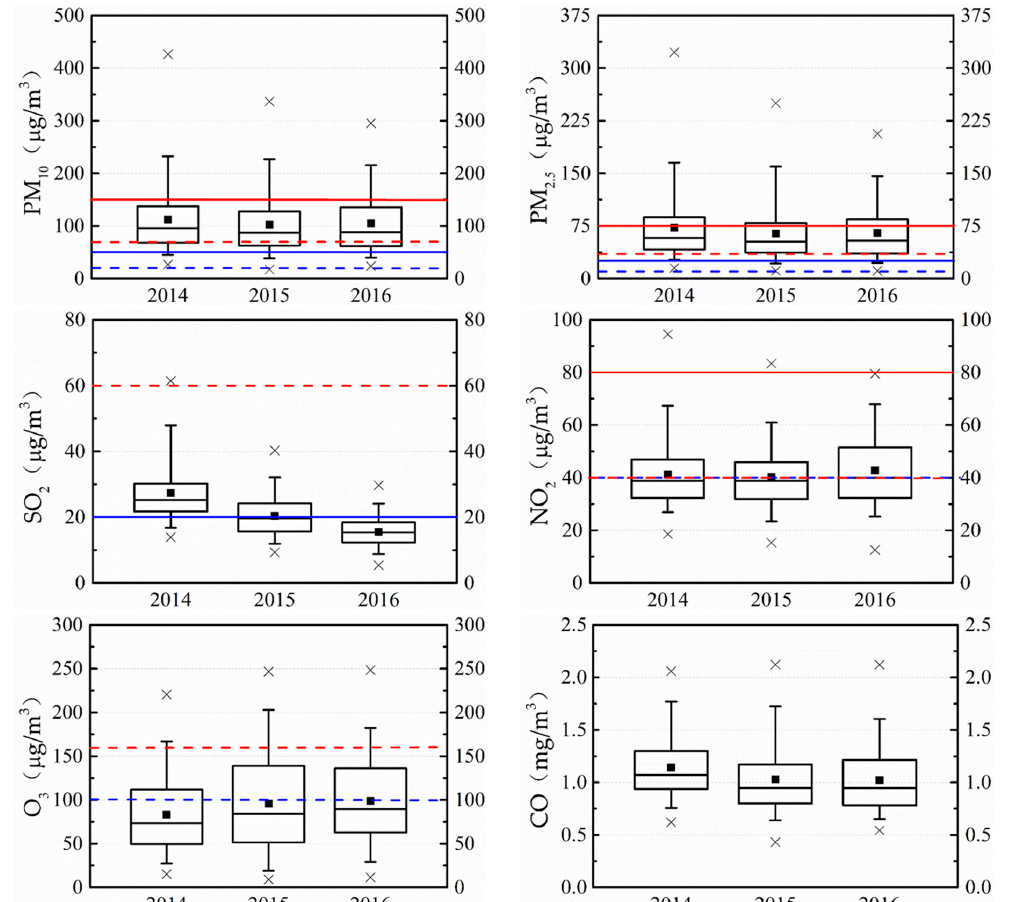
Figure 2. The city-wide average annual and daily concentrations of PM 10 , PM 2.5 , SO 2 , NO 2 , O 3 and CO in Chengdu during the study period. The horizontal solid lines indicate the median and the filled squares indicate the mean (i.e., annual average concentrations), and range where the top and bottom of the box indicate the 75th and 25th percentiles, respectively. The top and bottom whiskers indicated the 95th and 5th percentiles, and the forks indicated the maximum and minimum values, respectively. The red solid and dotted lines represent the daily and annual limits specified by CAAQS (Chinese Ambient Air Quality Standards), the blue solid and dotted lines represent the daily and annual limits specified by the WHO.